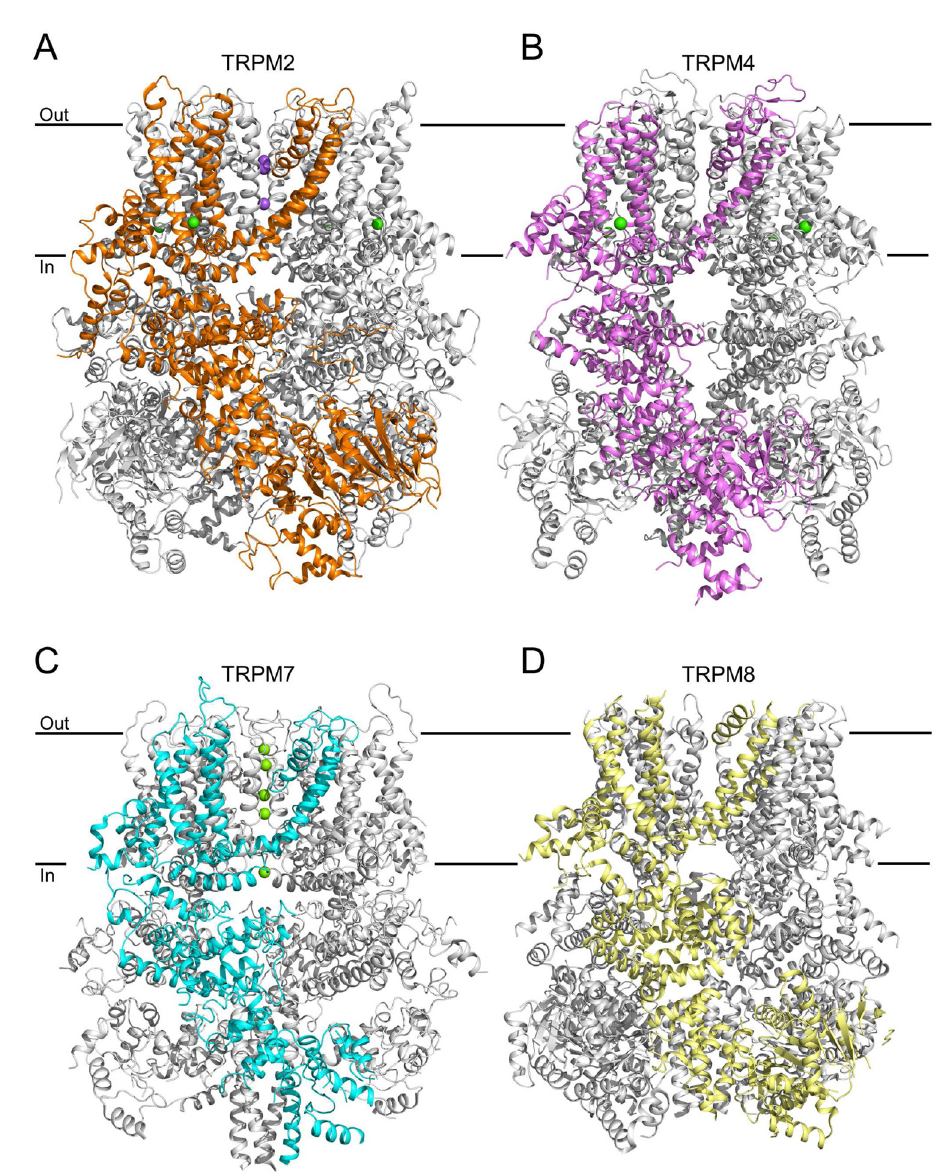
Figure 3. TRPM family members exhibit a conserved global structural architecture. Cryo-EM structures of ( A ) TRPM2 (PBD 6CO7), ( B ) TRPM4 (PDB 6BQV), ( C ) TRPM7 (PDB 6BWD) and ( D ) TRPM8 (PDB 6BPQ). One monomer of the respective tetrameric channel structure is highlighted. Spheres denote: Ca 2+ (green) and Na + (purple) ions in TRPM2; Ca 2+ ions (green) in TRPM4; and Mg 2+ ions (green) in